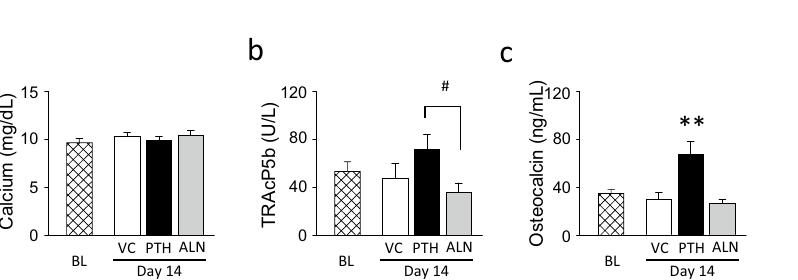
Figure 2. ALN induced greater diaphyseal trabecular bone with suppressed osteoclasts than VC or PTH. ( a ) Representative images of HE-stained sections of tibiae at the injury level. Arrows indicate drilling sites; open circles indicate newly formed ossified tissue; closed circles indicate periosteal ossified tissue. ( b ) The average endosteal bone area at the local intramedullary injury level was significantly larger in the PTH and ALN groups than the VC group. No significant difference was found between the PTH and ALN groups although a trend of the larger bone area in the ALN vs. PTH group was observed. ( c ) Representative images of TRAP-stained sections of the endocortical ossified tissue. ( d ) Osteoclast numbers per bone perimeter were significantly smaller in the ALN group than the VC or PTH group. No differences were noted between the PTH and VC groups. * p < 0.05 vs. VC, # p < 0.05 between PTH and ALN.